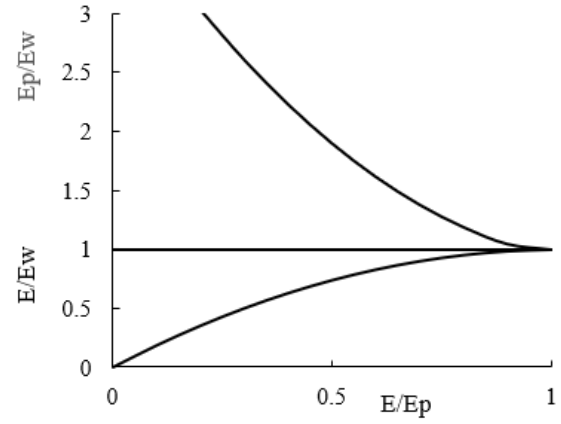
Figure 2. B2015 generalized complementarity.